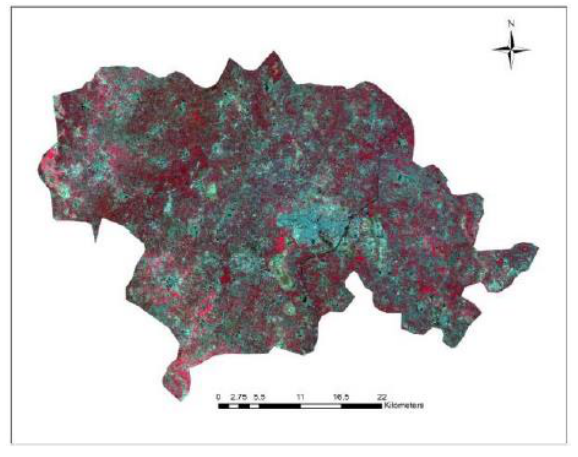
Fig 2: Canal and surface drain network in Rohtak district